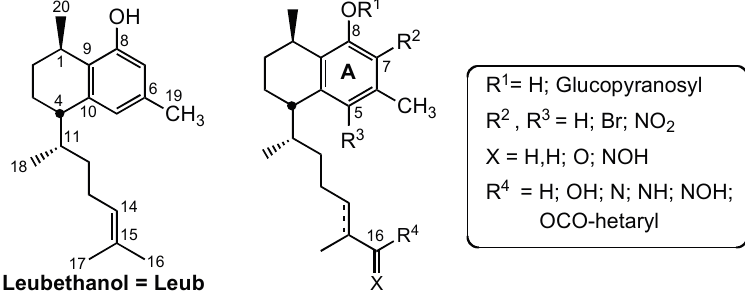
Figure 1. Leubethanol modifications on ring A and the alkyl side